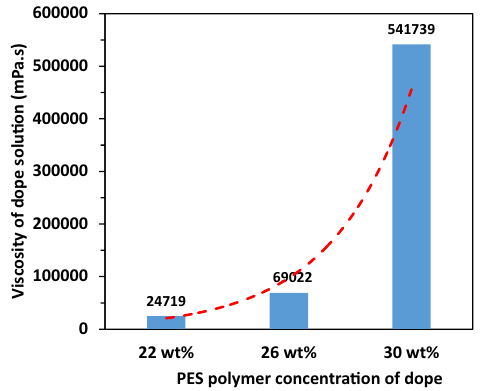
Fig. 1 Bulk viscosities of the polymer dopes (composition: PES/NMP/ H 2 O/CaCl 2 ) with different PES concentrations. The dash line (red) is an exponential trend line for the sake of visualizing the increase of the viscosity with the